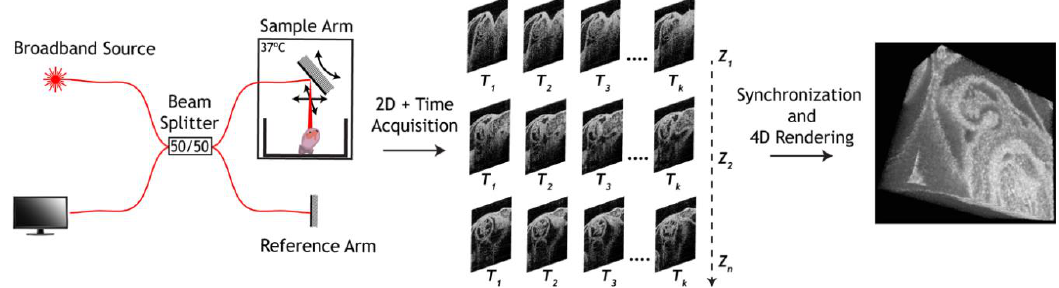
Figure 2. 4-D OCT cardiodynamic embryonic imaging in parallel slice geometry. Reproduced with permission from